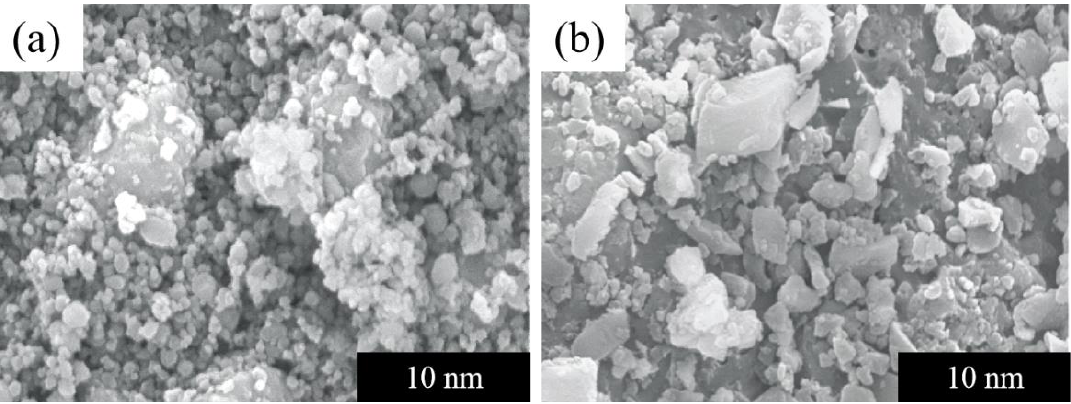
Figure 8. SEM comparison of ( a ) hydrophilic ZrO 2 -SiO 2 , ( b ) hydrophobic ZrO 2 -SiO 2 xerogels.